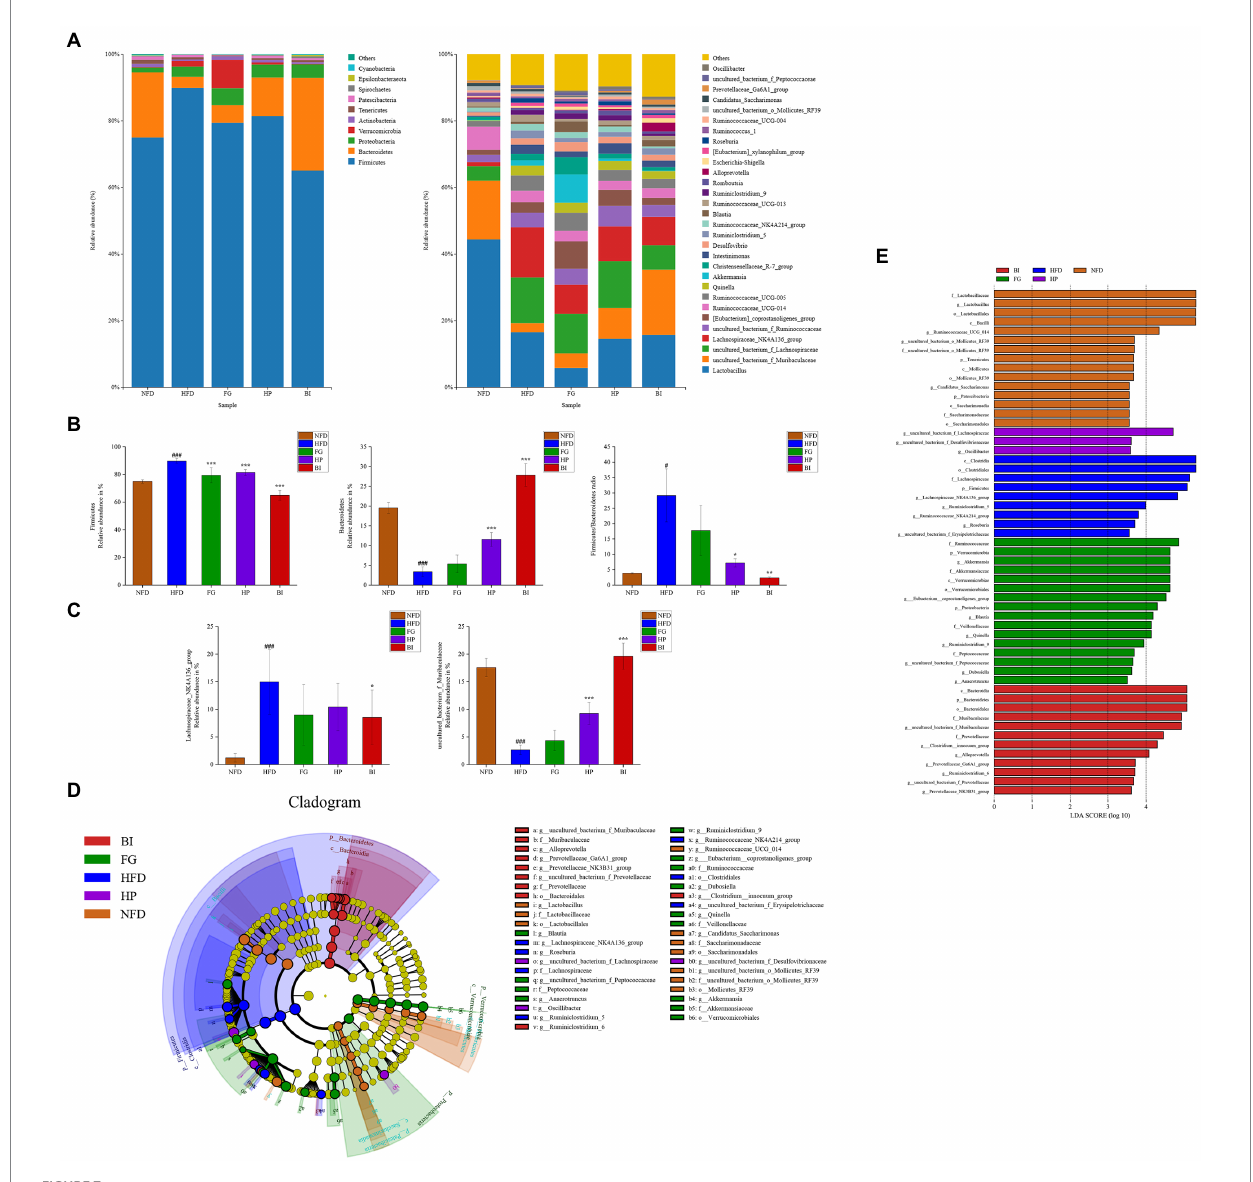
FIGURE 7 Effect of FG, HP and BI on the microbiota composition in HFD-fed rats. (A) Composition of intestinal microbiota at the phylum and genus level. (B) The abundance of Firmicutes, Bacteroidetes and the ratio of Firmicutes and Bacteroidetes in each group. (C) The abundance of Lachnospiraceae_ NK4A136_group, uncultured_bacterium_f_Muribaculaceae in each group. (D) LEfSe comparison of intestinal microbiota among five experimental groups. (E) Linear discriminant analysis (LDA) of five experimental groups. Significantly different from NFD group, # p < 0.05, ### p < 0.001. Significantly different from HFD group, * p < 0.05, ** p < 0.01, *** p <